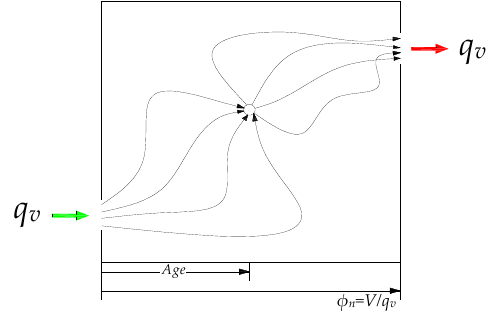
Figure 5. Definition of the age of air [27].